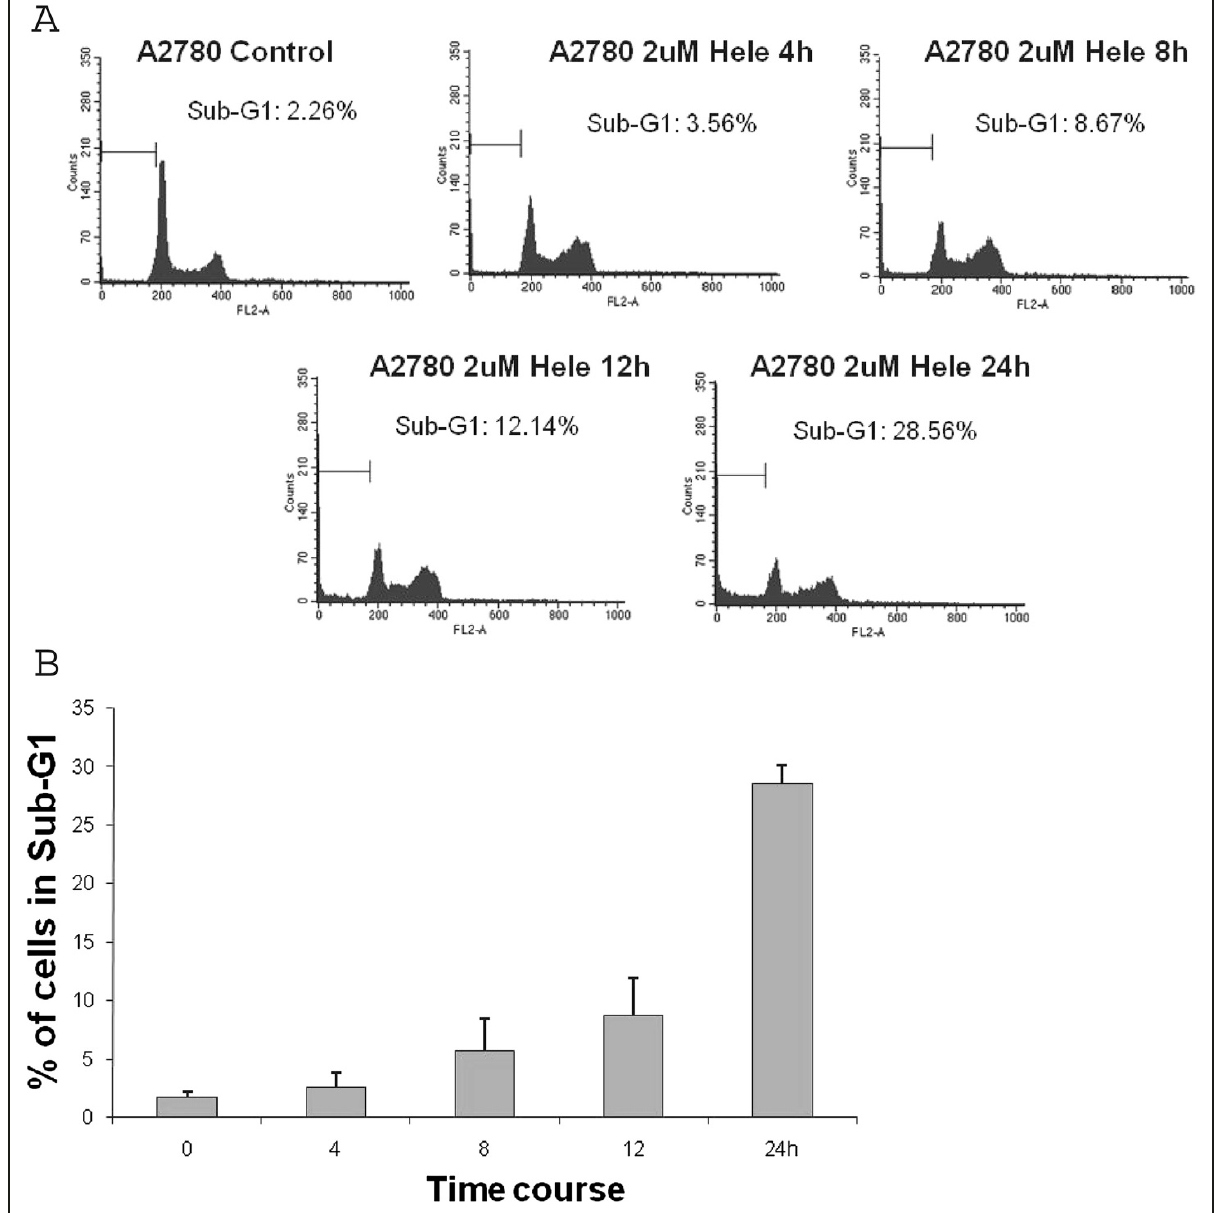
Figure 3 Helenalin induces cell cycle arrest in G1 phase and modulates apoptosis in a time-dependent manner. ( A ) 1.85×105 cells/ml were seeded onto 6-well plates and incubated for 24 h. 2uM of helenalin was added to the culture medium and incubated for 4,8,12 and 24 h. Cells were harvested and analyzed by flow cytometry. The cell cycle phase distribution was determined using CellQuest software. Figures represent data from three independent experiments. ( B ) Percent of cells in Sub-G1 after the indicated timepoints representing three biological